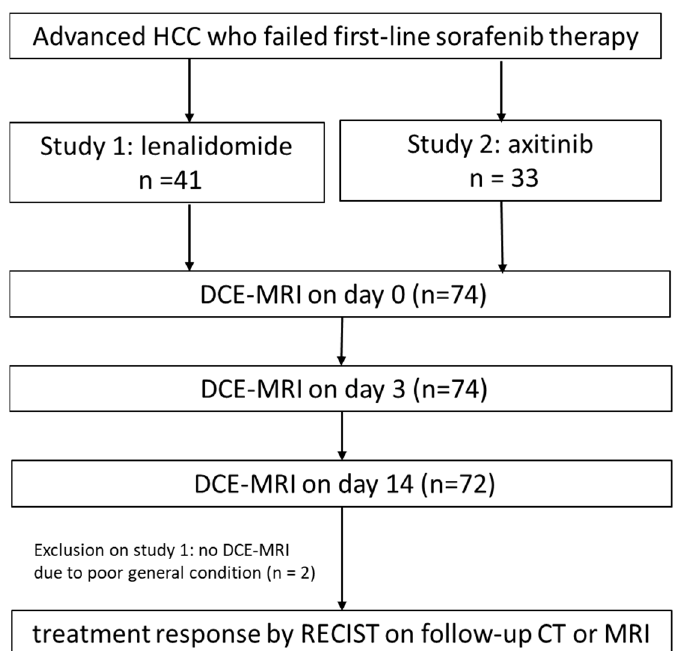
Figure 1. Study flowchart presenting a summary of the final study participants. HCC = hepatocellular carcinoma; RECIST = Response Evaluation Criteria in Solid Tumors; DCE = dynamic contrast enhanced.